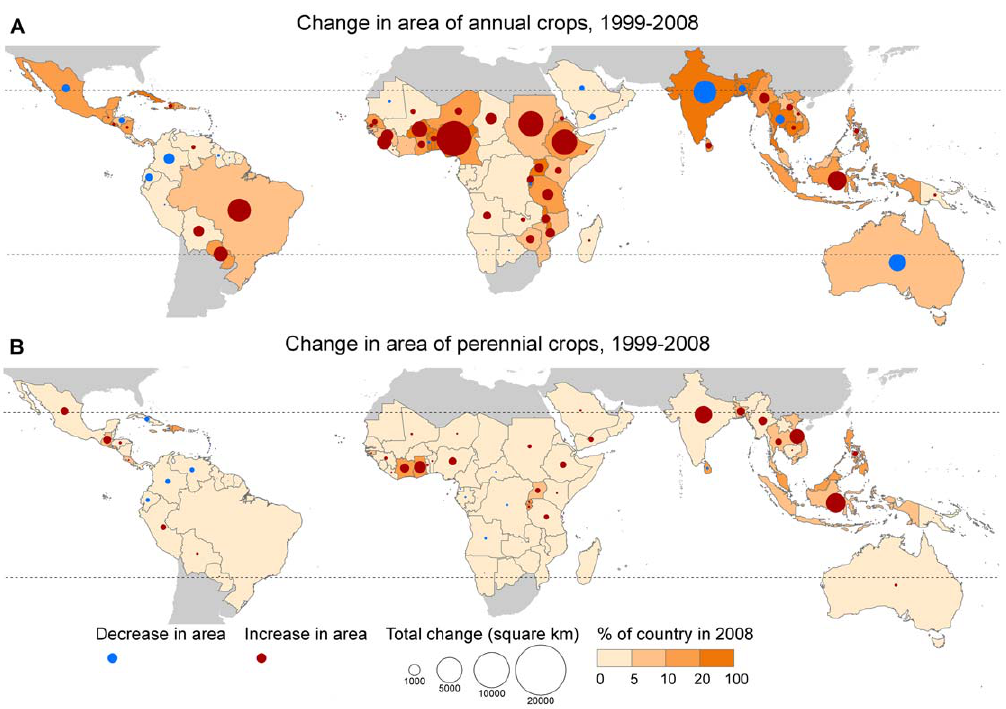
Figure 4. Increments in the area devoted to cropland in tropical countries. Circles show absolute increment over the period 1999–2008, with scale exaggerated 10 times for ease of interpretation. Shading indicates percentage of each country occupied by annual crops in 2008. Countries not defined as tropical are shaded grey. Maps are based on land data, for (A) arable land (annual crops) and (B) permanent cropland (perennial crops). Source: [46].